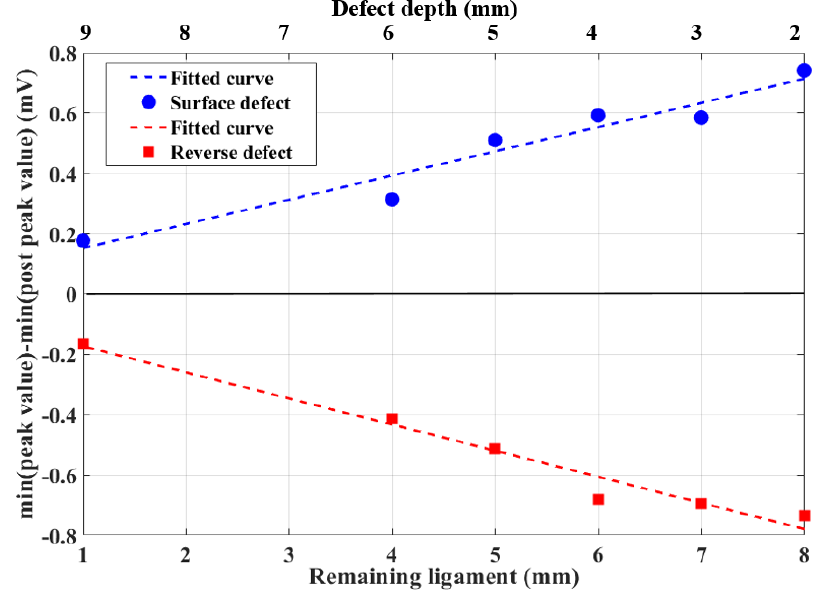
Figure 10. Di ff erence value of minimum in B x curves of peak and postpeak Figure 10. Difference value of minimum in B x curves of peak and postpeak values.